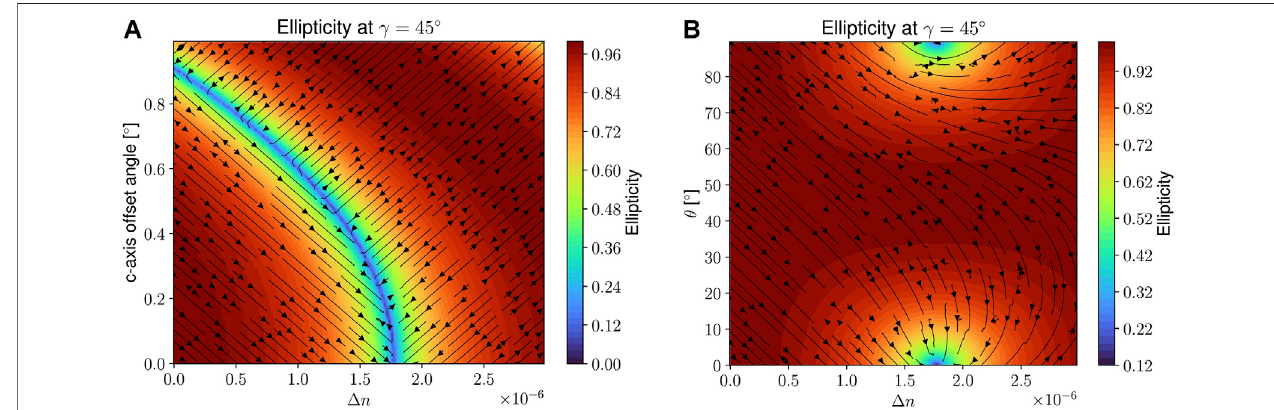
FIGURE 7 | Ellipticity and ellipse-orientation plots as a function of an offset-angle between c-axis and surface-normal (A) and θ for different Δ n . The (B) plot ’ s ellipticity graph is the same as in Figure 6 . In both graphs, γ is set to 45 ° while α = 0 ° .